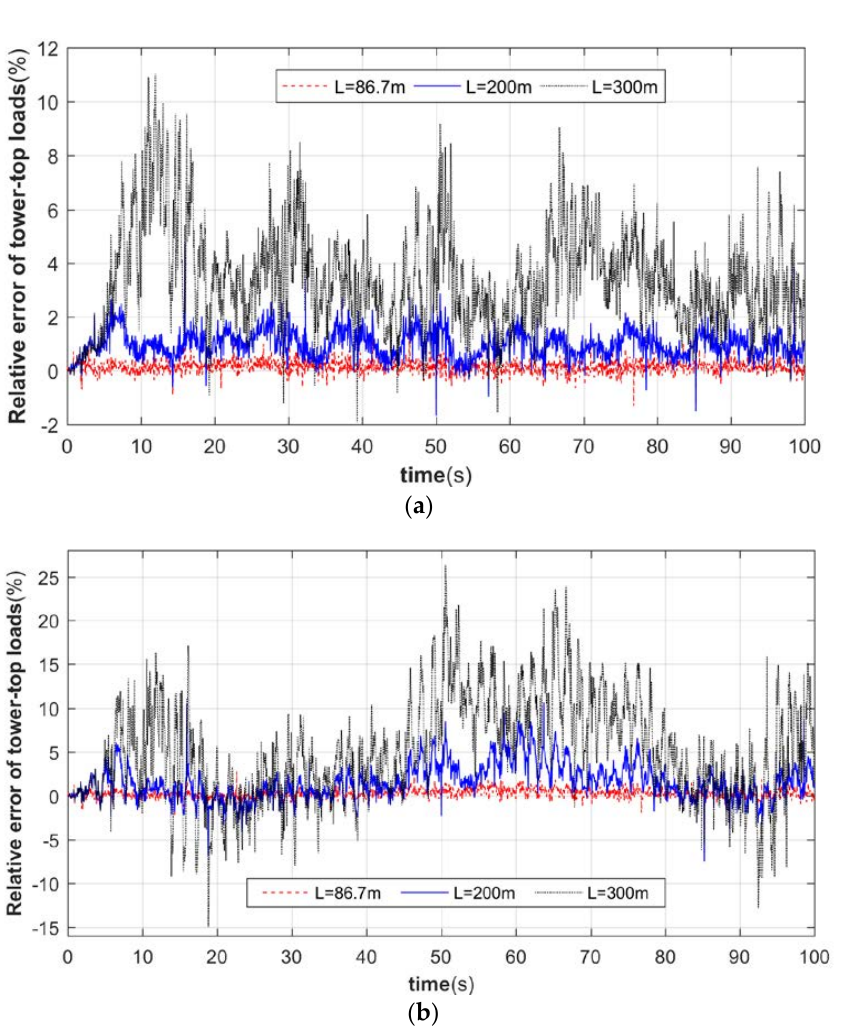
Figure 8. Relative error analysis of tower top load. ( a ) Longitudinal thrust. ( b ) Lateral thrust.